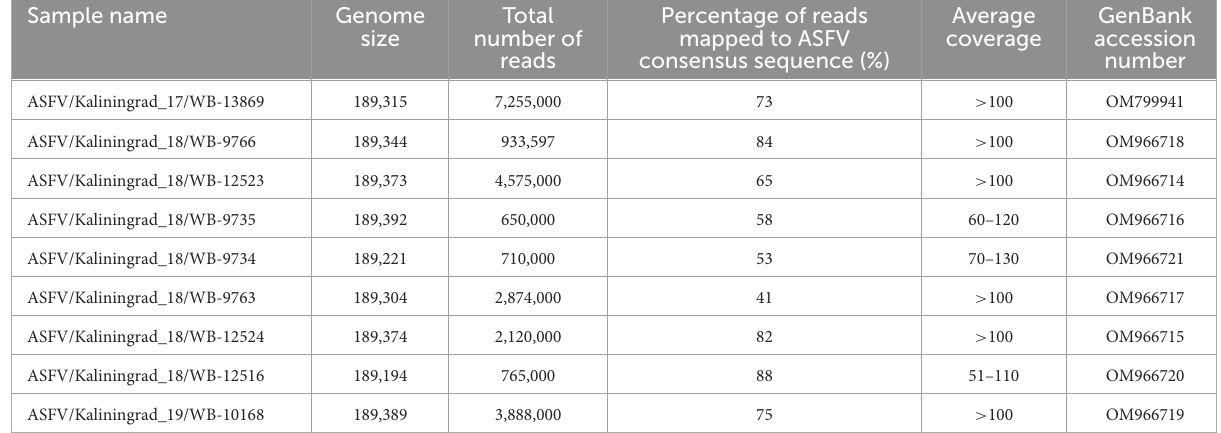
TABLE 2 Whole-genome sequencing data for all nine ASFV isolates from Kaliningrad and GenBank accession